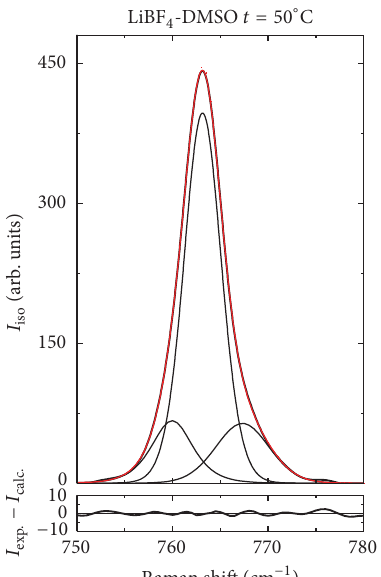
Figure 6: Free anions and ion pairs in the spectrum of the totally symmetric ] 1 (A 1 ) vibration of BF 4− in the DMSO solution containing 0.15 mole fractions of LiBF 4 .